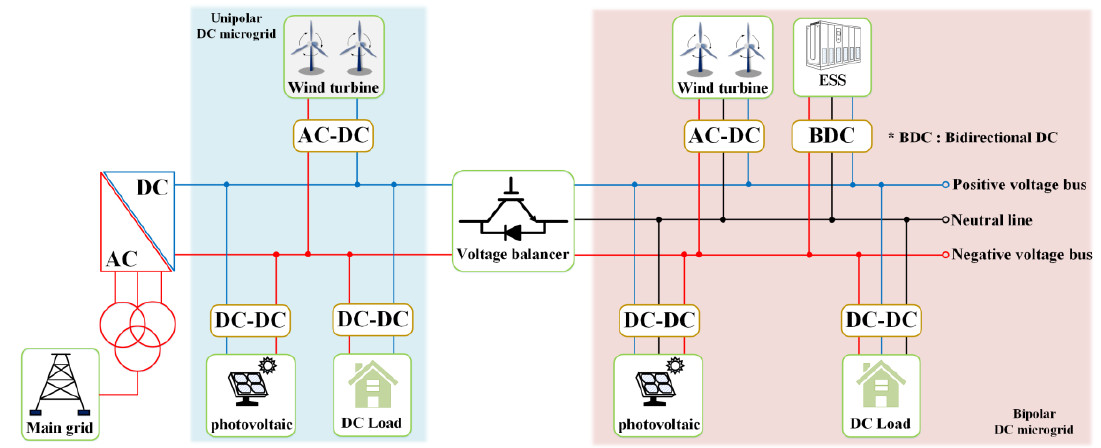
Figure 1. Block diagram of DC microgrid based on unipolar and bipolar voltage bus.